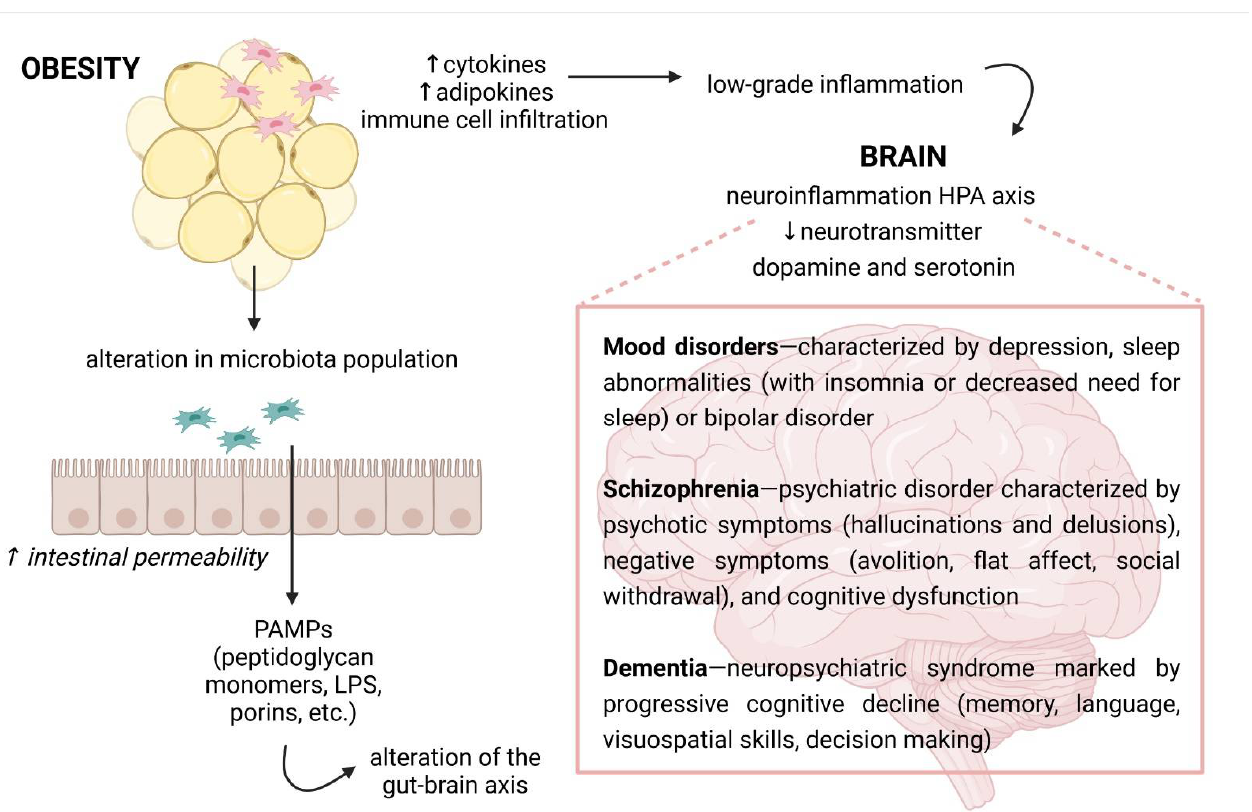
Figure 2. The possible links between obesity and neurological disorders. Because of a high secretion of cytokines and adipokines by the adipose tissue where immune cells infiltrate, obesity is recognized by chronic low-grade inflammation. Overnutrition is also linked with changes in gut microbiota composition and increased intestinal permeability. Then, it leads the activation of an immune response through microbial or pathogen-associated molecular patterns, e.g., pathogen-associated molecular patterns (PAMPs), such as lipopolysaccharide (LPS). The inflammatory molecules can reach the circulation and the central nervous system, where they may cause neuroinflammation. In turn, the immune activation in the brain can influence the hypothalamus–pituitary–adrenal (HPA) axis and neurotransmitter signaling, affecting cognition and behavior. Own drawing, based on [116] .